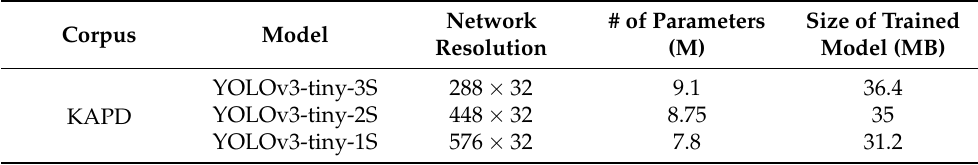
Table 1. Characteristics of the YOLOv3-tiny